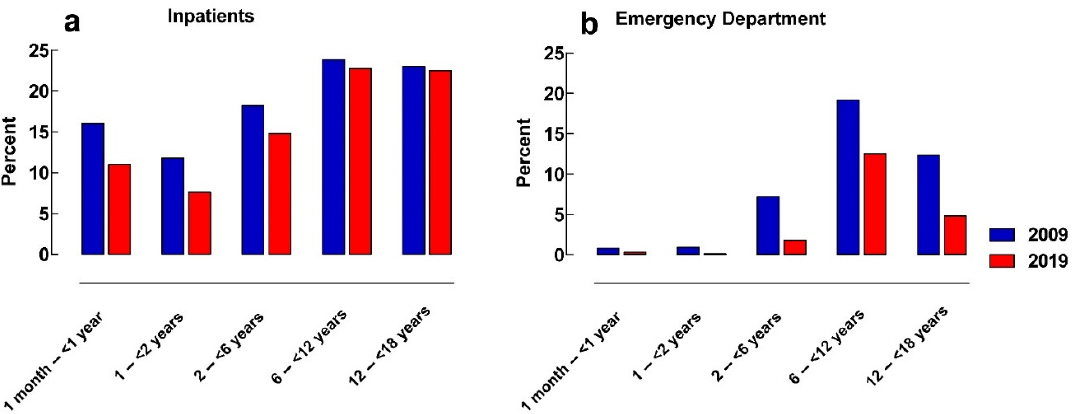
Figure 1. Frequency of patients with manipulated solid oral medicines in different age-groups in: ( a ) inpatients; ( b ) patients at the emergency department. The percentages of manipulations including halves of oral dosage forms (i.e.,